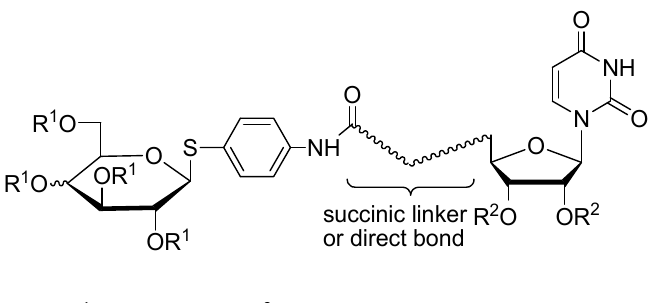
Scheme 2. General structure of tested glycoconjugates used in this study.